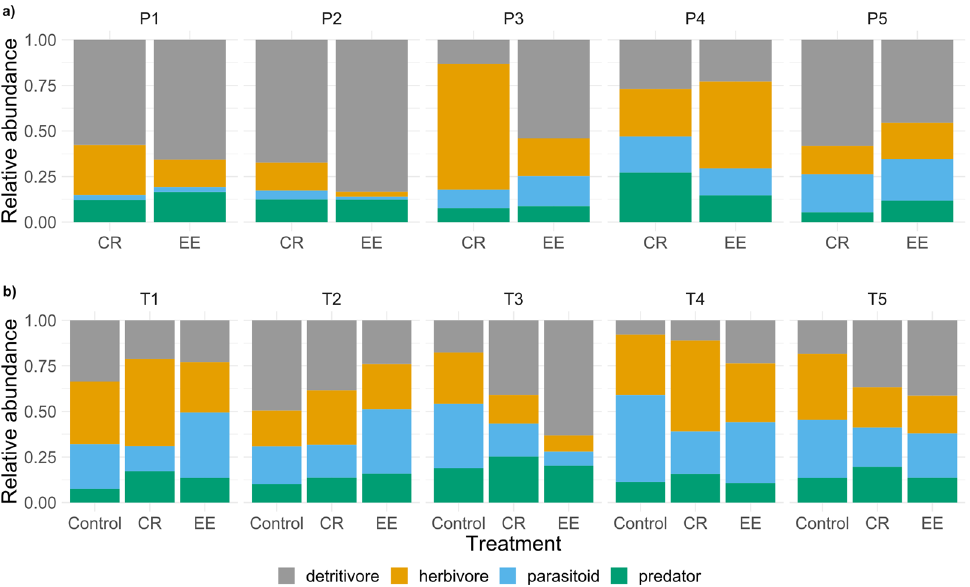
Figure 2. Relative abundance of the functional groups per rice field collected in different treatments (CR = conventional rice field; EE = ecologically engineered field; control). Rice fields were compared in pairs (P1–P5) during the ( a ) dry season and compared in trios (T1–T5) during the ( b ) wet season.